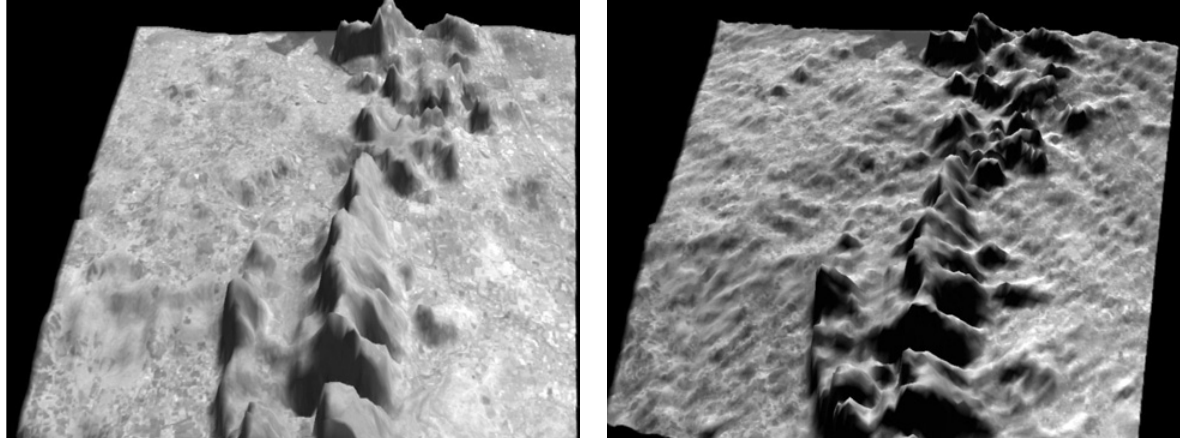
Fig. 3. 3D surfaces generated from SOI & SRTM DEM at different